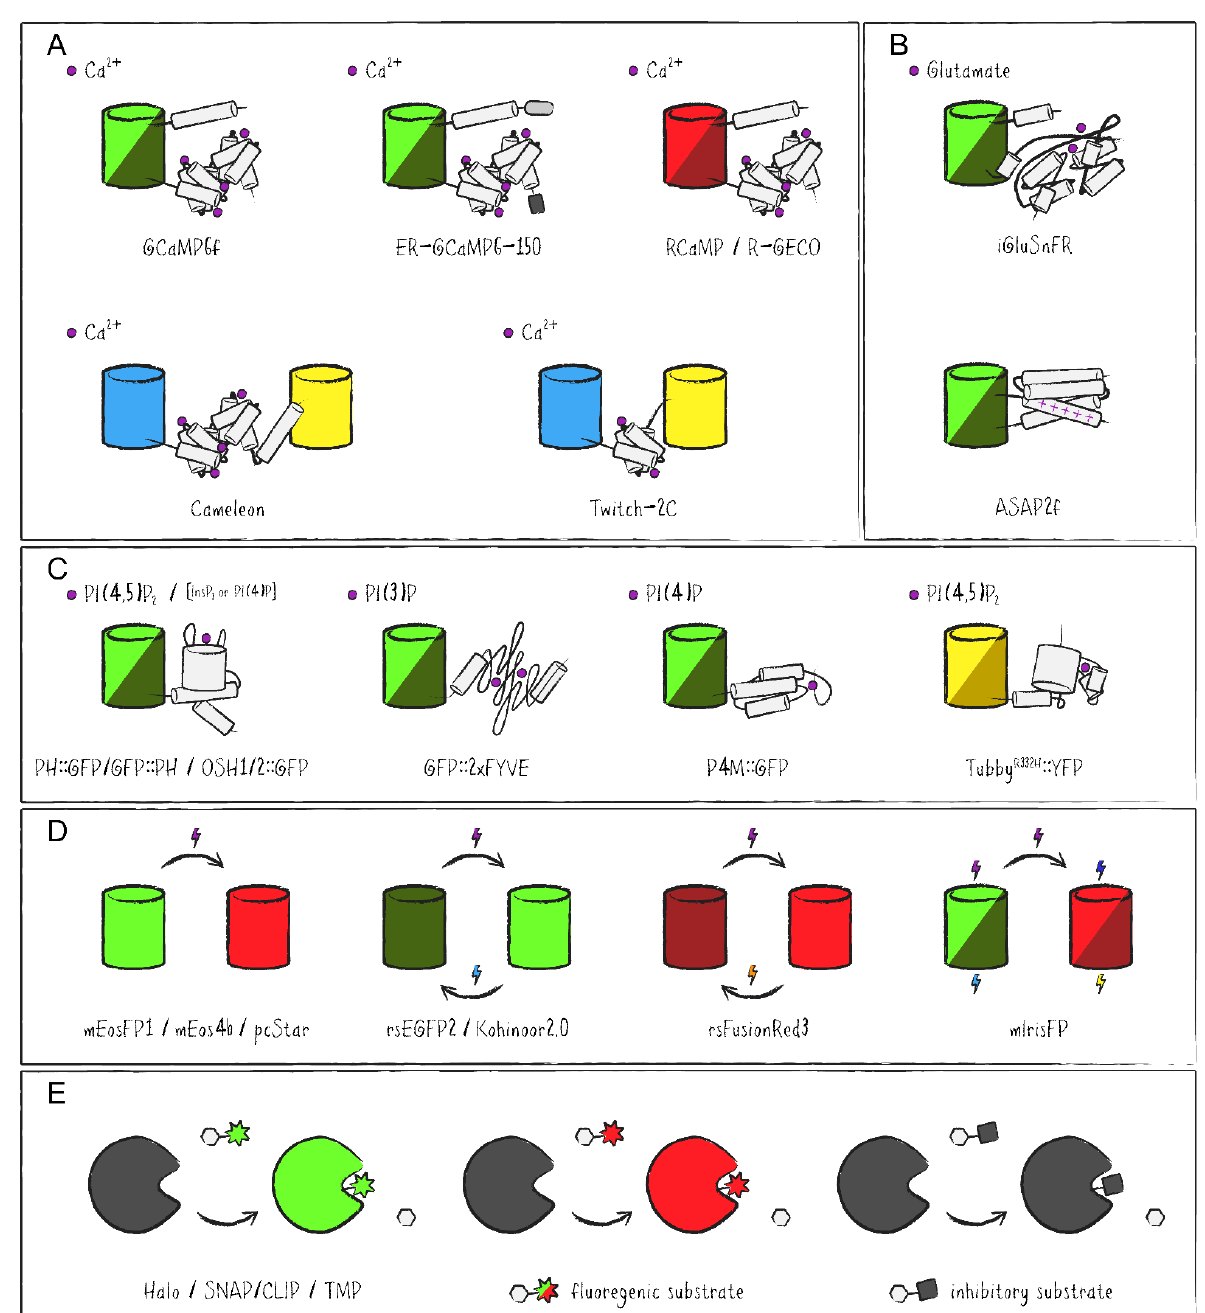
Figure 5. Schematic representation of fluorescent proteins (FPs) and FP fusion proteins with applications in the functional dissection of the Drosophila visual system. ( A ) Fluorescent genetically encoded calcium indicators based on conformational changes in singular circularly permuted (cp)FPs (GCaMP6f, ER-GCaMP6-150, RCaMP, R-GECO) or FRET probes (Cameleon, Twitch-2C) in response to Ca 2+ binding. ( B ) Fluorescent biosensors for neuronal activity reacting to changes in extracellular glutamate concentration (iGluSnFR) or membrane potential (ASAP2f). Purple circles represent respective binding sites. ( C ) Phospholipid binding probes (PH::GFP, GFP::PH, OSH1/2::GFP, GFP::2xFYVE, P4M::GFP, Tubby R322H ::YFP) for imaging intracellular pools of phosphoinositides like PI(3)P, PI(4)P, PI(4,5)P 2 and InsP 3 . ( D ) Examples of advanced variants of FPs capable of photoconversion from green to red fluorescence (mEosFP1, mEos4b, pcStar), reversible photoswitching from an “OFF” state to an “ON” state (rsEGFP2, Kohinoor2.0, rsFusionRed3) or both (mIrisFP). ( E ) Extrinsically fluorescent protein tags able to covalently bind specific fluorogenic or inhibitory substrates allowing rapid chemical labeling (Halo, SNAP/CLIP,